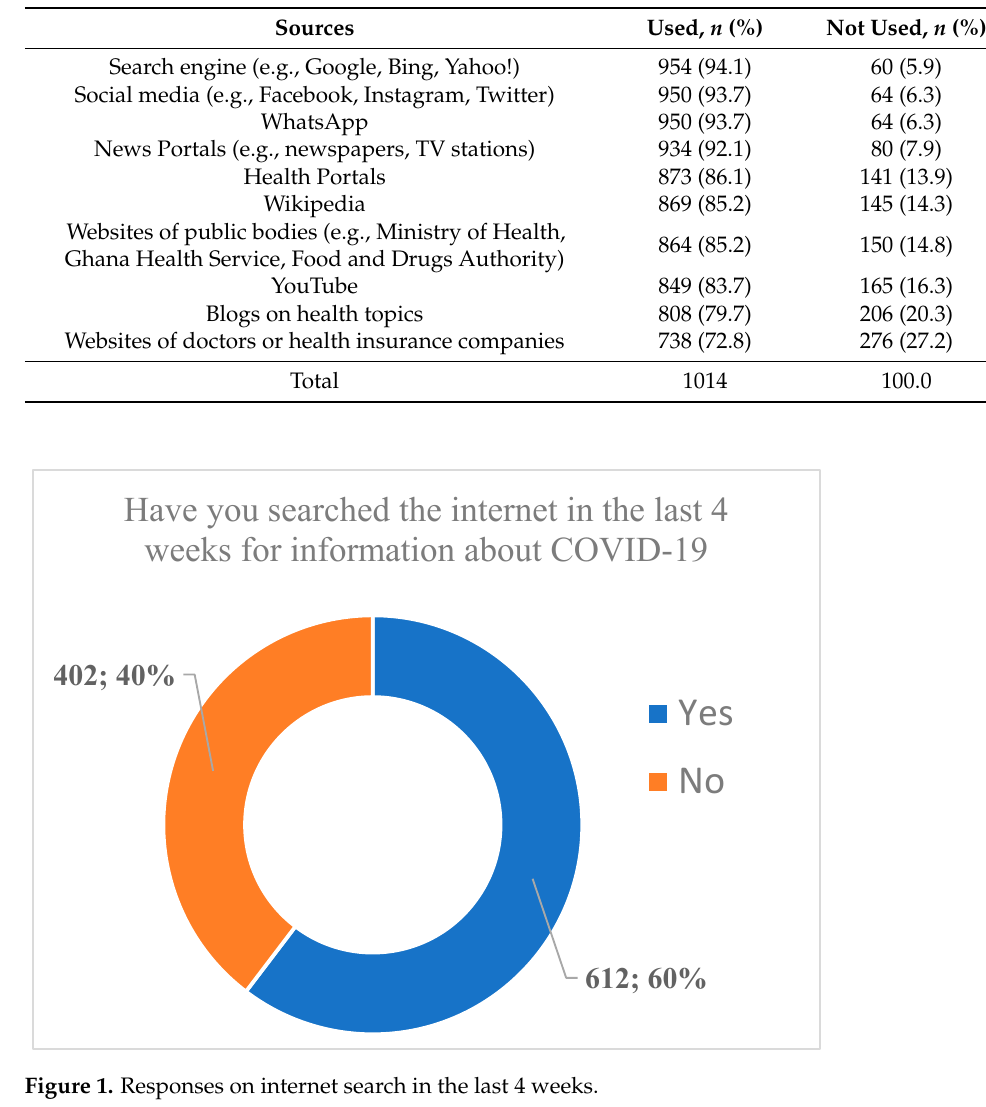
Table 2. Distribution of responses on the sources of information-seeking platforms ( n = 1014).